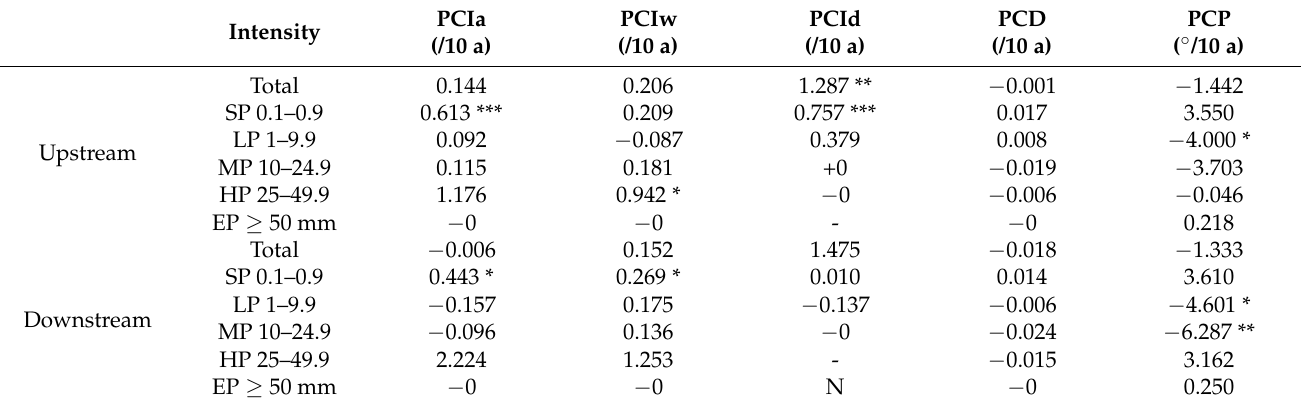
Table 5. Trends in PCI, PCD and PCP in each intensity over the LRB during